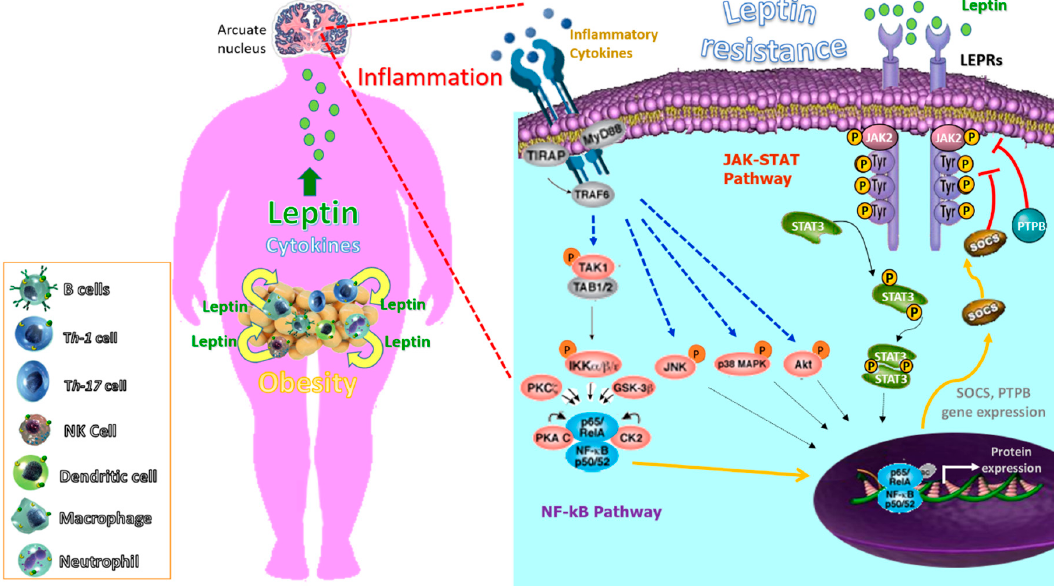
Figure 2. Inflammation contributes to leptin resistance in the brain at the hypothalamic arcuate nucleus, and as a result, alters food intake and energy expenditure leading to obesity. Adipocytes and central nervous system (CNS) cells interact via several secreted factors. In obesity, the adipose tissue is characterized by hypertrophy and increased infiltration of macrophages and other immune cells.